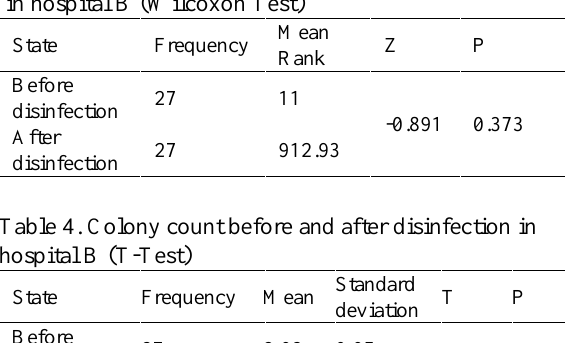
Table 3. Bacterial diversity comparing before and after disinfection in hospital B (Wilcoxon Test)